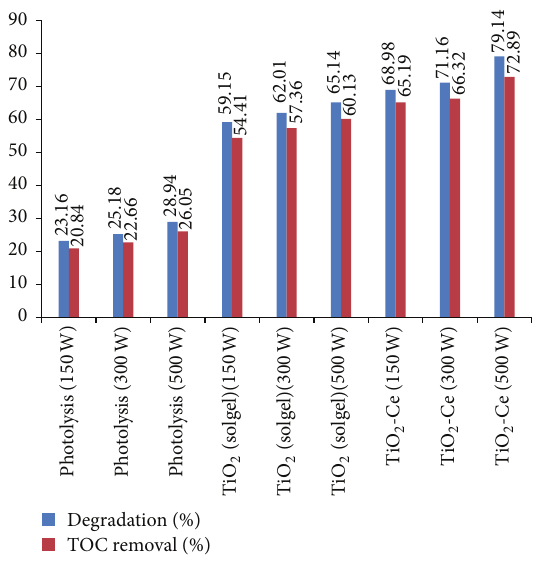
Figure 5: UV-DRIFT analysis of TiO 2 and TiO 2 -Ce catalyst.